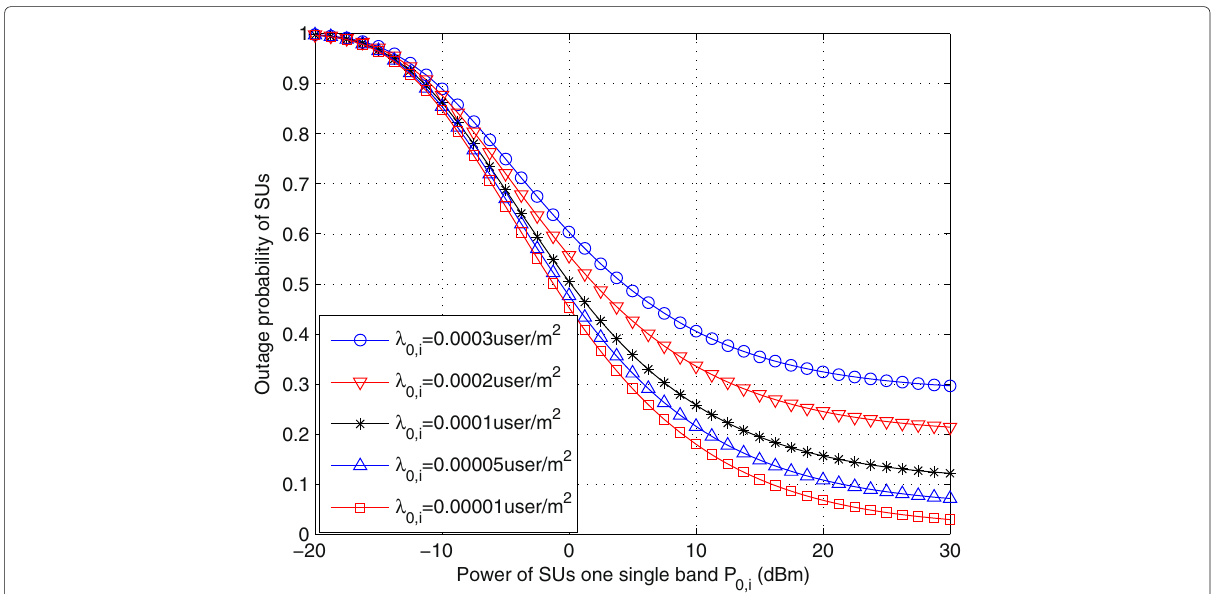
Fig. 3 Outage probability of SUs vs. power of SUs on one single